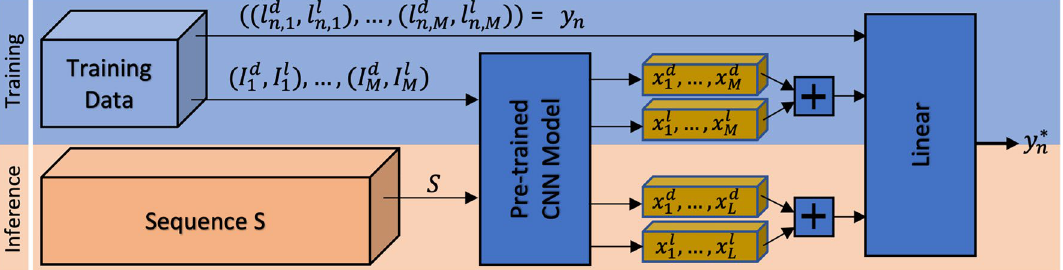
Figure 6. To train an individual multi-view landmark regressor h n , initially, the deep features ) are extracted of M annotated image pairs. Afterwards, the concatenated features x i = (( x d 1 , . . . , x d x l 1 , . . . , x l M , M of correspondent image pairs serve as input for the regressor training. The landmark positions y landmark pairs